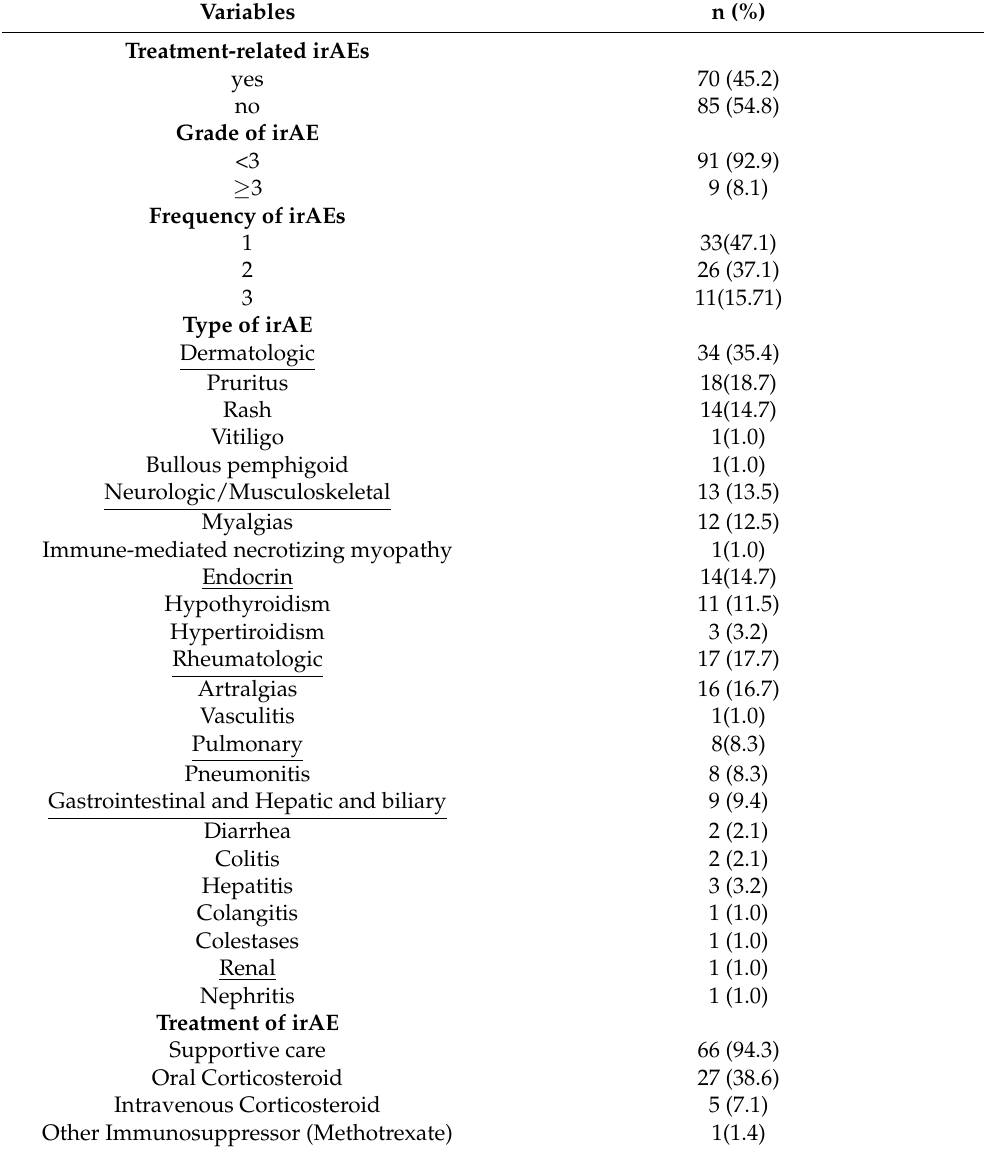
Table 2. Immune-related adverse events in the whole